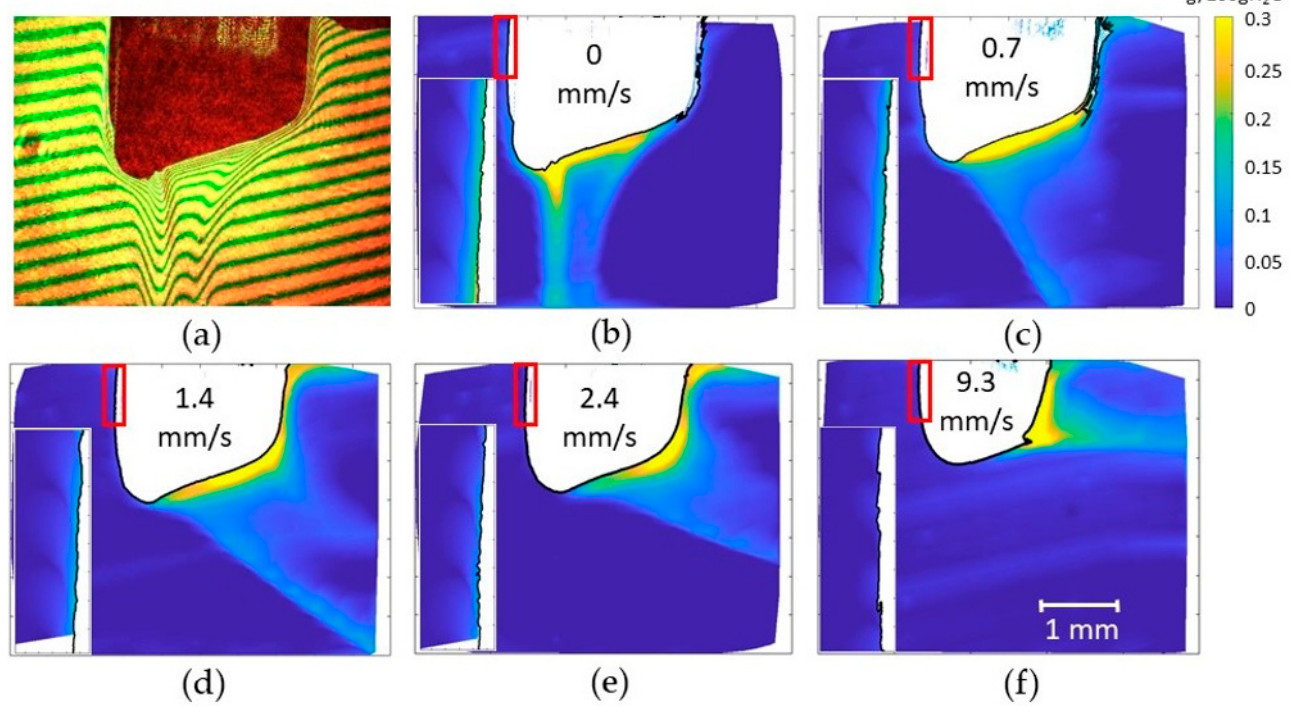
Figure 12. Dissolution in the 0.21 g/g solution. The inflow is from the left. ( a ) Original image at 𝑣 = 0 mm/s. ( b – f ) Concentration fields at increasing velocity (indicated in each image). The inserts show the marked section of the crystal–liquid interface with the resolution of CCD2.